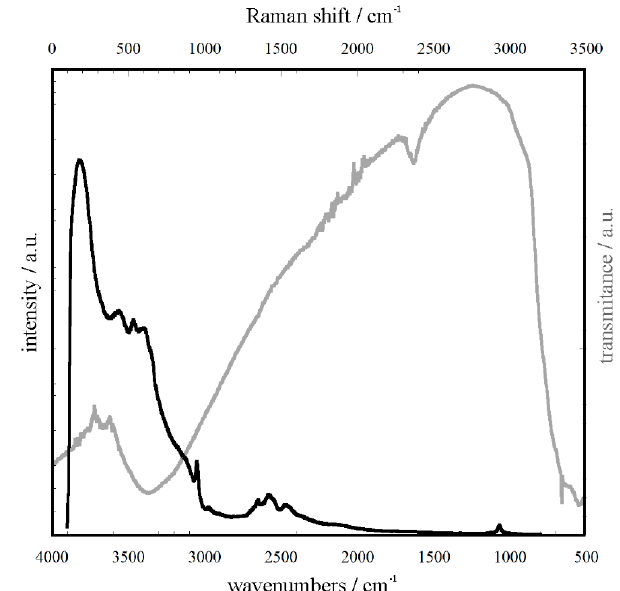
Figure 4. Raman ( black line ) and Attenuated Total Reflection-Fourier Transform Infra-Red (ATR-FTIR) ( grey line ) spectra of the synthesized titania.